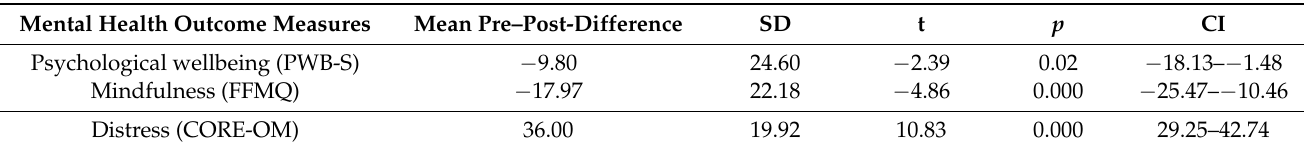
Table 7. Comparison of MTC group mental health outcome measures at pre- and post-intervention assessment (N =